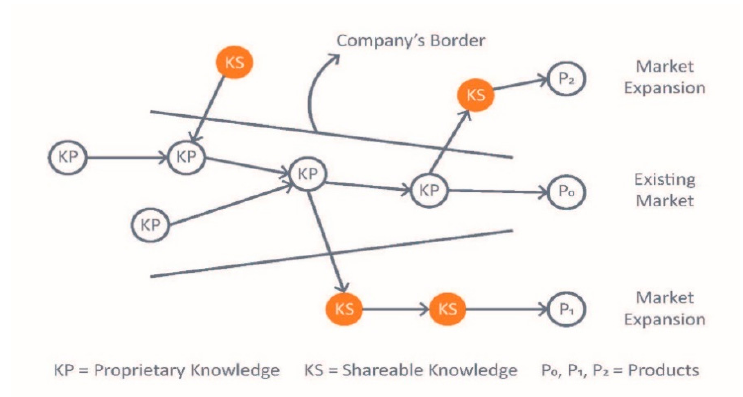
Figure 1. Open innovation in terms of proprietary and shareable knowledge.